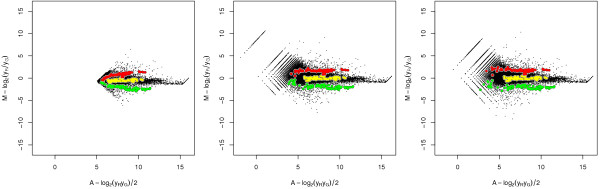
Log-ratios versus log-intensities before and after a robust affine normalization. Left: Non-normalized data. Spike-ins designed to have log2r = +2, 0, and -2 are highlighted in red, yellow and green, respectively. Middle: Affine normalization utilizing constraint (32) resulting in no negative signals. Parameter estimates used in back transformation are (a^G
MathType@MTEF@5@5@+=feaafiart1ev1aaatCvAUfKttLearuWrP9MDH5MBPbIqV92AaeXatLxBI9gBaebbnrfifHhDYfgasaacH8akY=wiFfYdH8Gipec8Eeeu0xXdbba9frFj0=OqFfea0dXdd9vqai=hGuQ8kuc9pgc9s8qqaq=dirpe0xb9q8qiLsFr0=vr0=vr0dc8meaabaqaciaacaGaaeqabaqabeGadaaakeaacuWGHbqygaqcamaaBaaaleaacqWGhbWraeqaaaaa@2F4A@, a^R
MathType@MTEF@5@5@+=feaafiart1ev1aaatCvAUfKttLearuWrP9MDH5MBPbIqV92AaeXatLxBI9gBaebbnrfifHhDYfgasaacH8akY=wiFfYdH8Gipec8Eeeu0xXdbba9frFj0=OqFfea0dXdd9vqai=hGuQ8kuc9pgc9s8qqaq=dirpe0xb9q8qiLsFr0=vr0=vr0dc8meaabaqaciaacaGaaeqabaqabeGadaaakeaacuWGHbqygaqcamaaBaaaleaacqWGsbGuaeqaaaaa@2F60@, log2β^
MathType@MTEF@5@5@+=feaafiart1ev1aaatCvAUfKttLearuWrP9MDH5MBPbIqV92AaeXatLxBI9gBaebbnrfifHhDYfgasaacH8akY=wiFfYdH8Gipec8Eeeu0xXdbba9frFj0=OqFfea0dXdd9vqai=hGuQ8kuc9pgc9s8qqaq=dirpe0xb9q8qiLsFr0=vr0=vr0dc8meaabaqaciaacaGaaeqabaqabeGadaaakeaaiiGacuWFYoGygaqcaaaa@2E64@) = (39.0, 22.0, -0.418). Right: Affine normalization where 5% (default) negative signals has been allowed; Parameter estimates used in back transformation are (a^G
MathType@MTEF@5@5@+=feaafiart1ev1aaatCvAUfKttLearuWrP9MDH5MBPbIqV92AaeXatLxBI9gBaebbnrfifHhDYfgasaacH8akY=wiFfYdH8Gipec8Eeeu0xXdbba9frFj0=OqFfea0dXdd9vqai=hGuQ8kuc9pgc9s8qqaq=dirpe0xb9q8qiLsFr0=vr0=vr0dc8meaabaqaciaacaGaaeqabaqabeGadaaakeaacuWGHbqygaqcamaaBaaaleaacqWGhbWraeqaaaaa@2F4A@, a^R
MathType@MTEF@5@5@+=feaafiart1ev1aaatCvAUfKttLearuWrP9MDH5MBPbIqV92AaeXatLxBI9gBaebbnrfifHhDYfgasaacH8akY=wiFfYdH8Gipec8Eeeu0xXdbba9frFj0=OqFfea0dXdd9vqai=hGuQ8kuc9pgc9s8qqaq=dirpe0xb9q8qiLsFr0=vr0=vr0dc8meaabaqaciaacaGaaeqabaqabeGadaaakeaacuWGHbqygaqcamaaBaaaleaacqWGsbGuaeqaaaaa@2F60@, log2β^
MathType@MTEF@5@5@+=feaafiart1ev1aaatCvAUfKttLearuWrP9MDH5MBPbIqV92AaeXatLxBI9gBaebbnrfifHhDYfgasaacH8akY=wiFfYdH8Gipec8Eeeu0xXdbba9frFj0=OqFfea0dXdd9vqai=hGuQ8kuc9pgc9s8qqaq=dirpe0xb9q8qiLsFr0=vr0=vr0dc8meaabaqaciaacaGaaeqabaqabeGadaaakeaaiiGacuWFYoGygaqcaaaa@2E64@) = (45.7, 27.0, -0.418). The rotated binning effects of data points at low intensities are due to (unnecessary) rounding of average spot pixel intensity to nearest integer by the image analysis software.